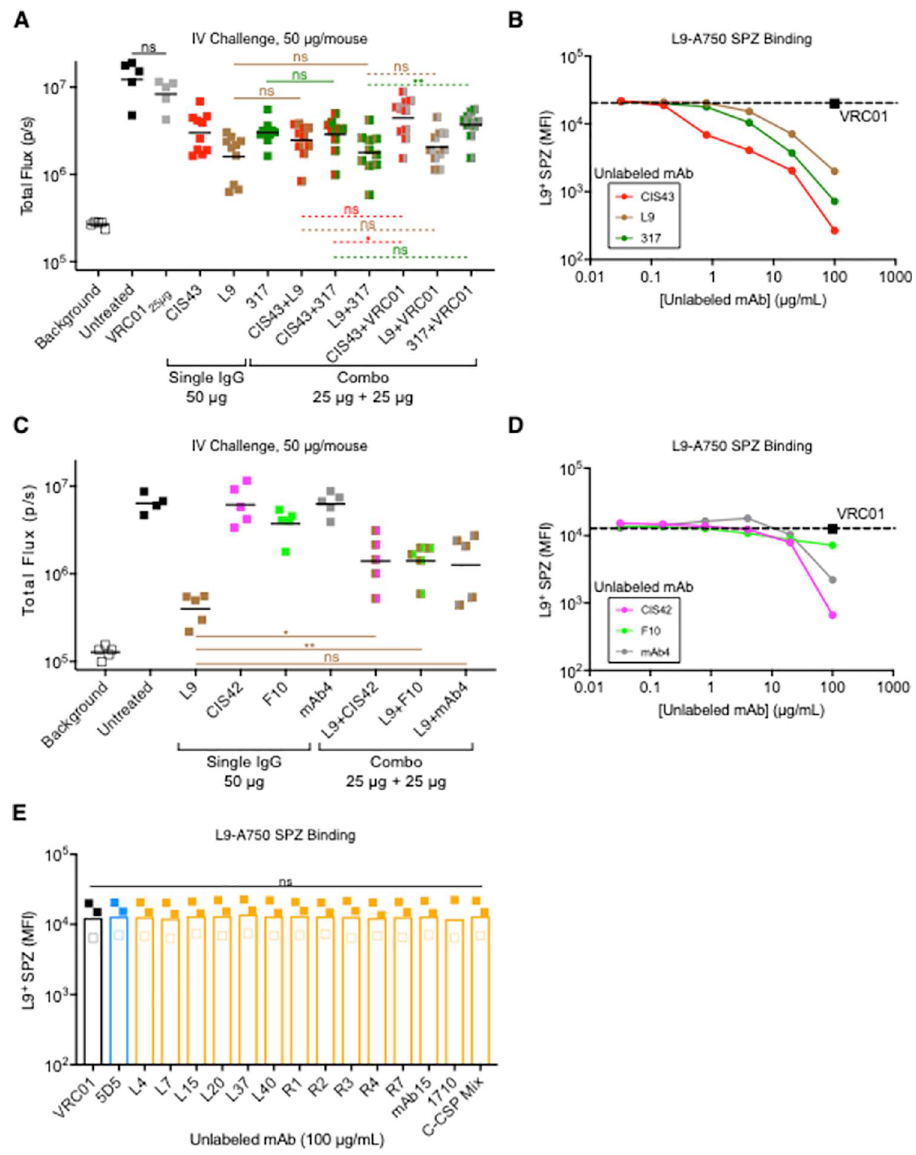
Fig 6. Repeat mAb combinations do not cooperatively neutralize SPZ in vivo and antagonize the SPZ binding of other repeat mAbs in vitro . (A) Liver burden in mice 40 hours post-challenge (n = 10/group) mediated by CIS43, L9, and 317 alone (50 μ g) and in combination with each other or isotype control VRC01 (25+25 μ g) administered 2 hours before IV challenge with 2,000 Pb-PfCSP-SPZ. P- values were determined by comparing PfCSP mAb combinations to L9 or 317 alone using the two-tailed Mann-Whitney test (solid lines) or PfCSP mAb combinations to their respective PfCSP mAb + VRC01 controls using the Kruskal-Wallis test (dotted lines). (B) MFI of Pb-PfCSP-SPZ bound by 2 μ g/ mL L9-AF750 when co-incubated with varying concentrations (0.032–100 μ g/mL) of unlabeled CIS43, L9, or 317. (C) Liver burden in mice 40 hours post-challenge (n = 5/group) mediated by L9, CIS42, F10, and mAb4 alone (50 μ g) and in combination (25+25 μ g) administered 2 hours before IV challenge with 2,000 Pb-PfCSP-SPZ. P- values were determined by comparing mAb combinations to L9 alone using the two-tailed Mann-Whitney test. (D) MFI of Pb- PfCSP-SPZ bound by 2 μ g/mL L9-AF750 when co-incubated with varying concentrations (0.032–100 μ g/mL) of unlabeled CIS42, F10, or mAb4. (E) MFI of Pb-PfCSP-SPZ (filled squares) and PfSPZ (open squares) bound by 2 μ g/ mL L9-A750 when co-incubated with 100 μ g/mL of specified unlabeled mAb. P- values were determined by comparing PfCSP mAbs to VRC01 using the Kruskal-Wallis test. (A, C): lines represent geometric mean. (B, D): dotted lines represent L9-AF750 co-incubated with 100 μ g/mL unlabeled VRC01; data are representative of two independent experiments. (A, C, E): ��� , p < 0.001; �� , p < 0.01; � , p < 0.05; ns (not significant), p > 0.05.